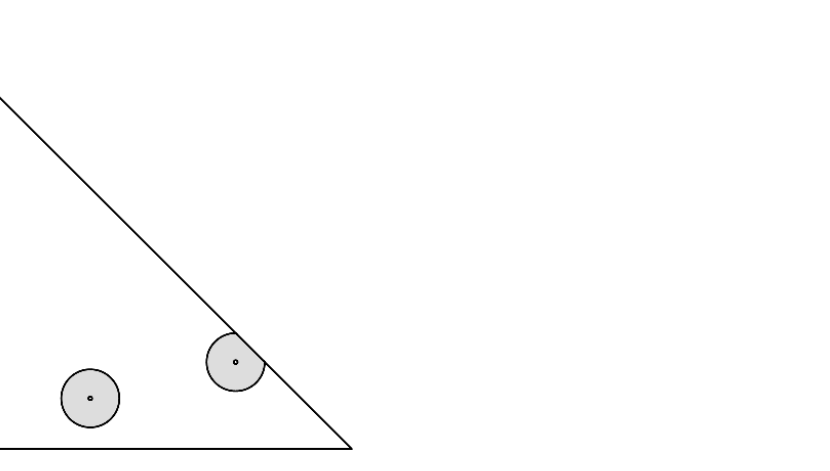
Figure 2. Geometric representation of different circular IFSs onto the IFS interpretation